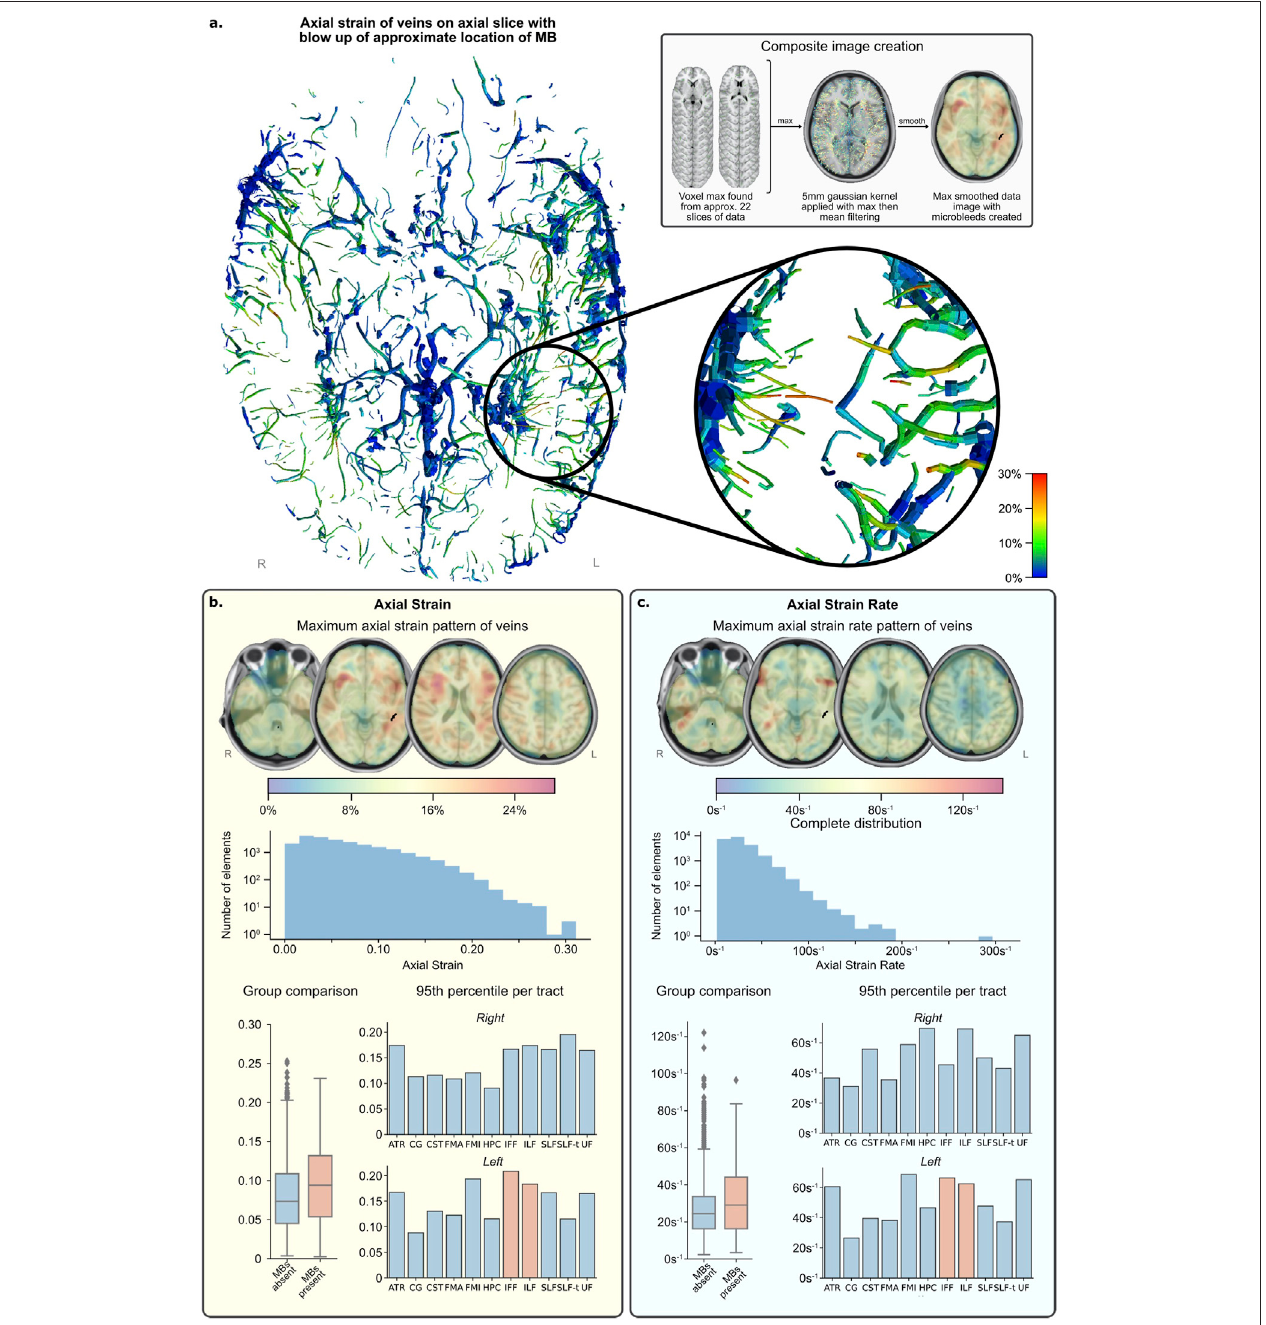
FIGURE 6 | FE simulation results. (A) Axial slice of inferior section of veins with maximum strain over time fringe colours. (lower right) Zoomed area of left temporal region shows several elements reaching peak strain levels (0.25 – 0.30) and is the approximate location of the MBs (upper right) Grey box shows image processing technique used to create composite images in (B,C) . (B) Vein axial strain results. (C) Vein axial strain rate results. NB. Strain and strain rate results (B,C) — henceforth called the data — present results in the same format: (top) composite images showing the pattern of data across all time with values calculated from maximum and mean fi ltering of raw data for visualisation; (middle) histogram of distribution of data from all vein elements in the simulation, not just those present in regions of interest; (bottom left) distribution of grouped regions with MBs compared to those without; (bottom right) 95th percentile of data per tract and per side, regions of interest with MBs present are highlighted in orange. Please see the Supplementary Figure S2 for the de fi nition of the tracts.